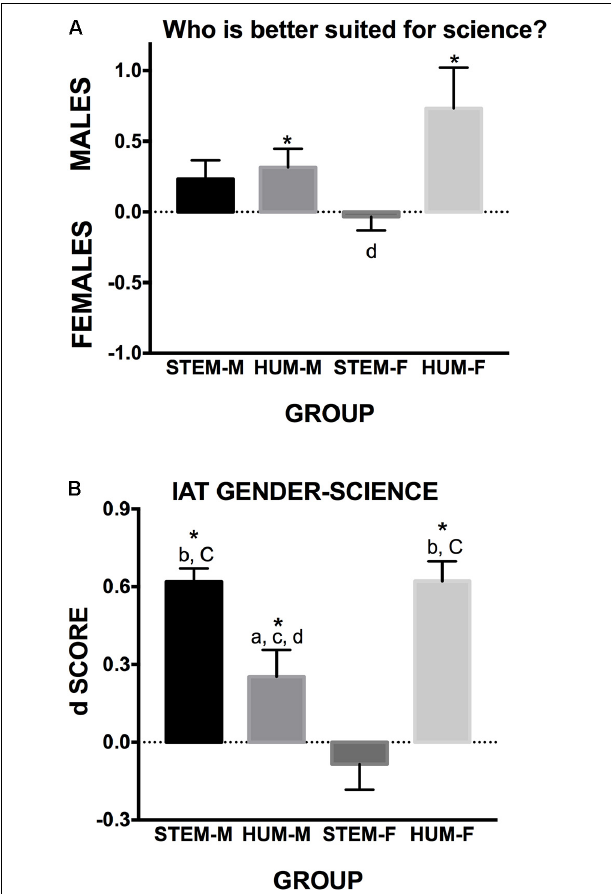
FIGURE 1 | Explicit beliefs and implicit associations. (A) Depicts explicit beliefs as to a different suitability of males and females for science studies/professions. (B) Illustrates the d -scores for IAT Gender-Science. ∗ Significantly different from zero, p < 0.05; letters denote statistically significant differences between groups: A different from STEM-Males, B different from HUM-Males, C different from STEM-Females and D different from HUM-Females (capital letters, p < 0.01; lowercase letters, p <